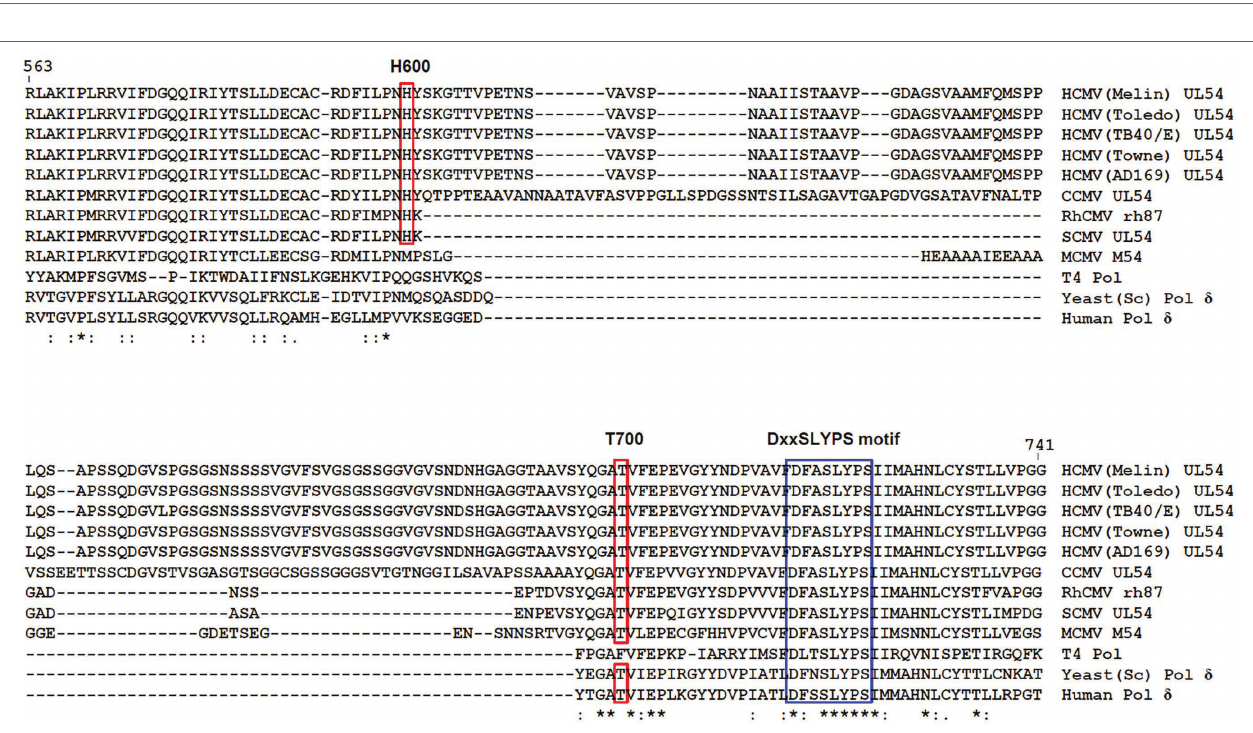
FIGURE 4 | Superposition of the HCMV DNA polymerase and yeast DNA polymerase δ ribbon models. The ribbon models of HCMV DNA polymerase (blue) and the ternary complex of yeast DNA polymerase δ (yellow, Protein Data Bank ID 3iAY) are superimposed in two different orientations (90 degrees). The DNA double helix is shown in the orange ribbon model. N- and C-termini are indicated.